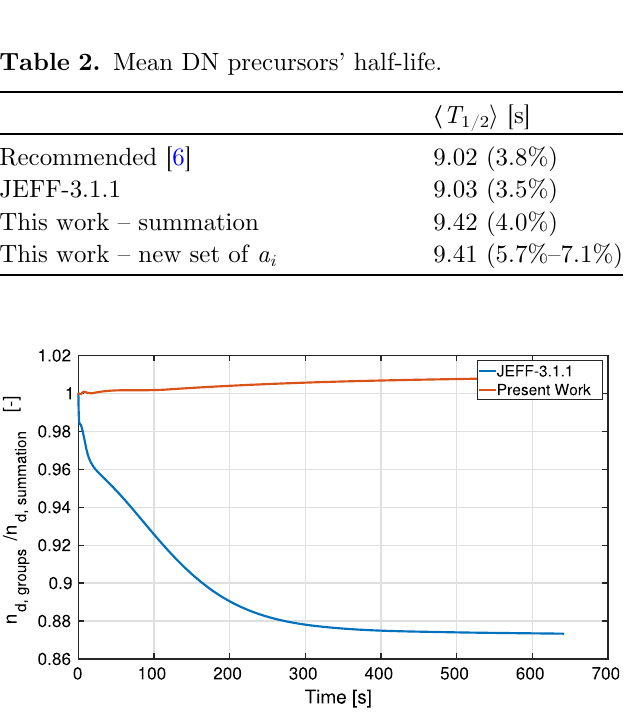
Fig. 2. Effect of the abundances on the DN activity.